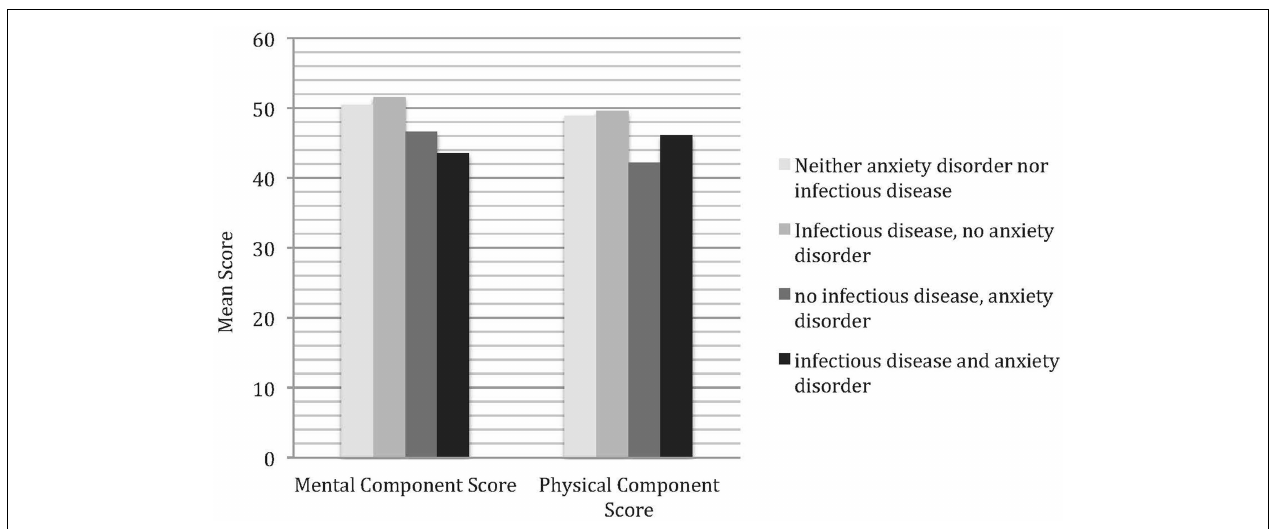
FIGURE 2 |The association of anxiety disorders and infectious diseases and health-related quality of life . Mean scores adjusted for sex.